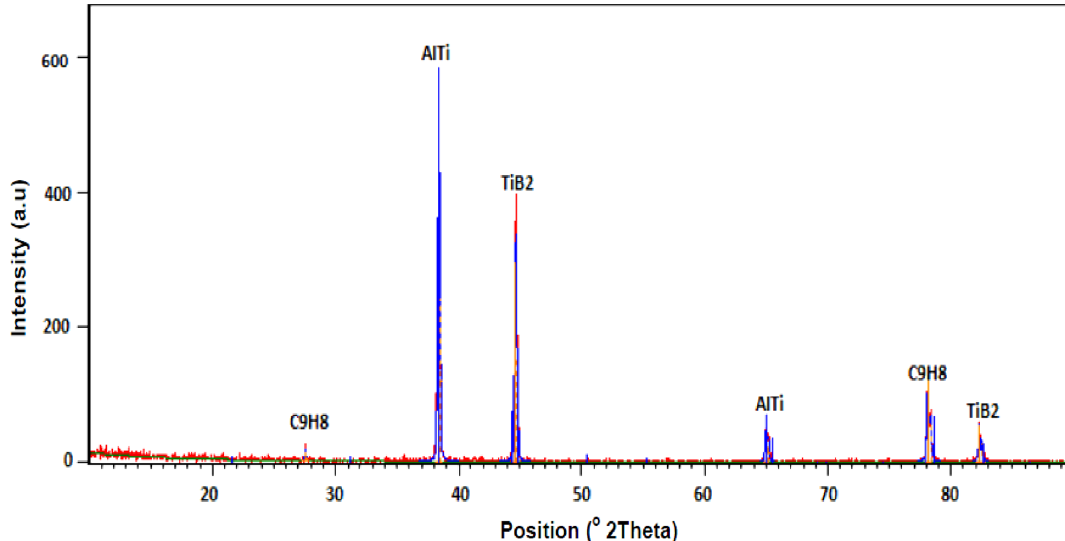
Figure 9. Energy dispersive X-ray analysis of TiB 2 coated plate joint.